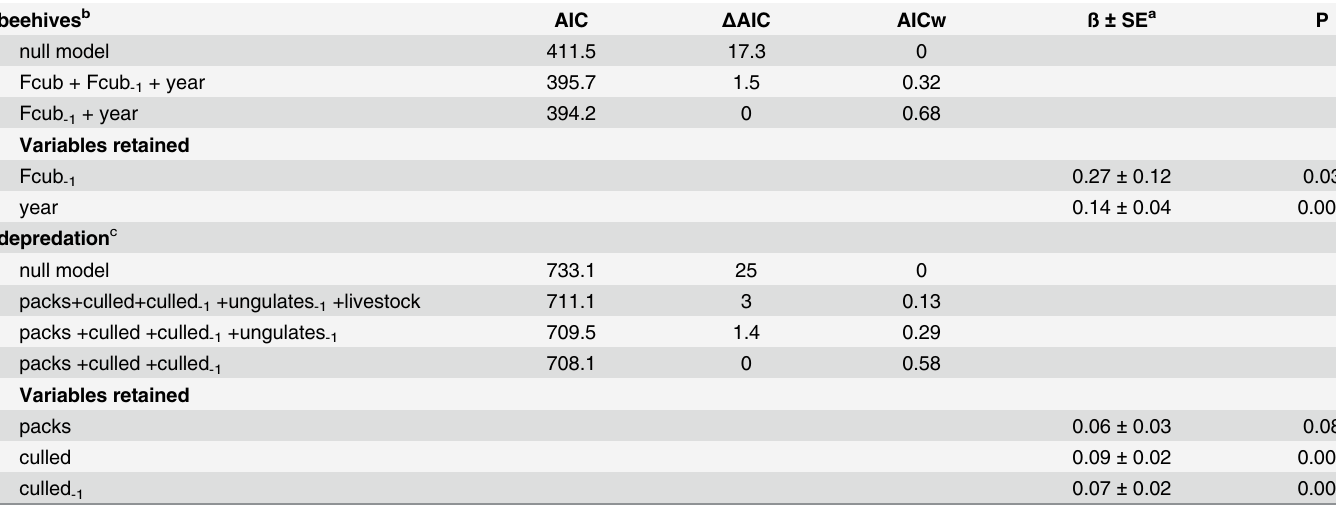
GLMM models with negative binomial distribution and zone as random factor. AIC is Akaike Information Criterion; Δ AIC is the difference between best model (lowest AIC) and each candidate model; AIC w are AIC weights. a Estimate and standard error for the variables retained in the best models.